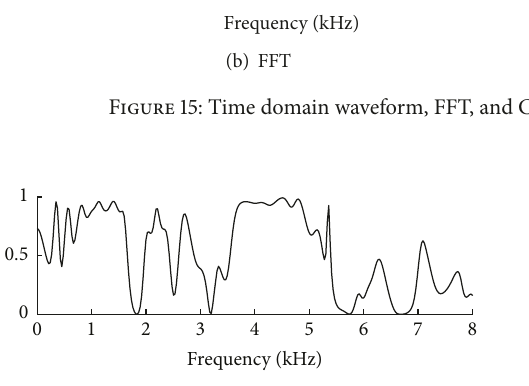
Figure 16: Correlation function of cylinder pressure and cylinder head vibration.